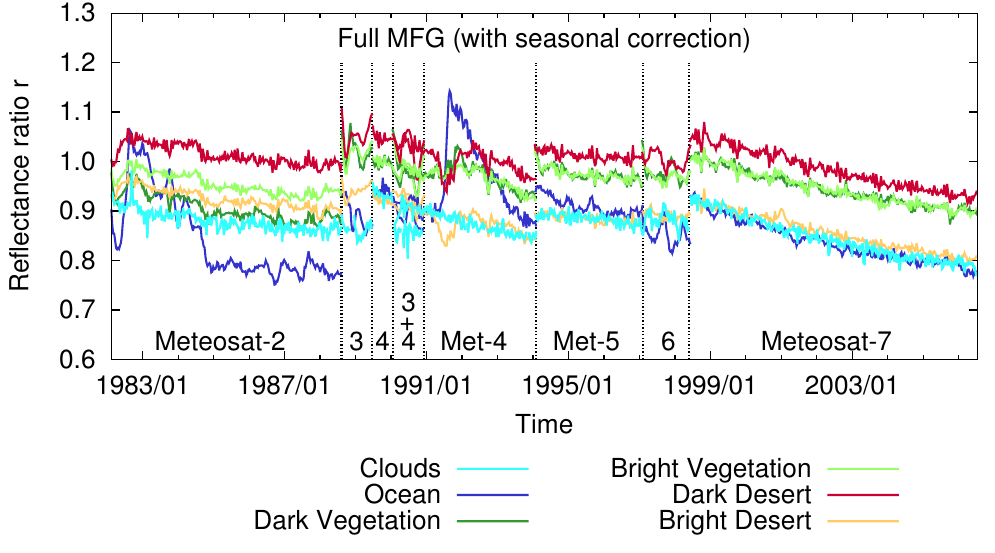
Figure 2. The original seasonal corrected time series for all 6 satellites from February 1982 until June 2006. The vertical lines show the switches of operational satellite at the nominal